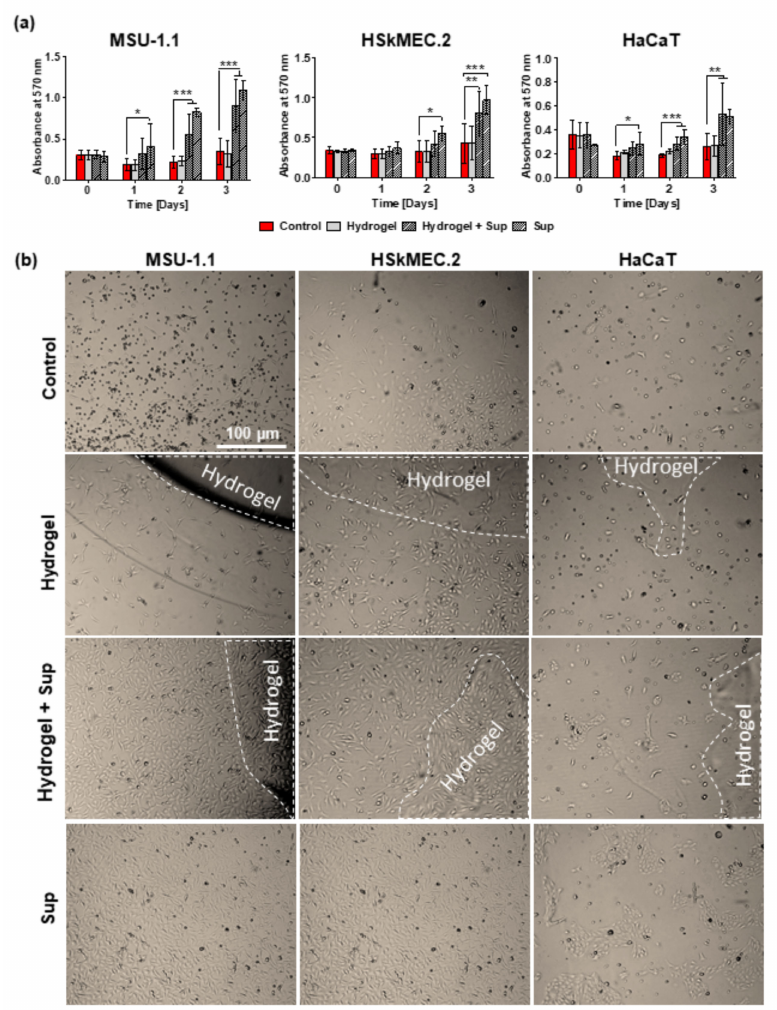
Figure 4. Proliferative activity of skin-derived cells under hydrogel-released HATMSC2 trophic factors. ( a ) Metabolic activity of MSU-1.1, HSkMEC.2 and HaCaT cells cultured in serum-free medium and 1% O 2 was measured by MTT assay at day 0, 1, 2 and 3 following treatment with empty hydrogel, supernatant-loaded hydrogel and 22 µ g HATMSC2 supernatant. Untreated cells were used as a control. Data represent mean ± SEM, n = 3, * p < 0.05, ** p < 0.01, *** p < 0.001. ( b ) Representative images of MSU-1.1, HSkMEC.2 and HaCaT alone, treated with empty hydrogel, supernatant-loaded hydrogel and 22 µ g HATMSC supernatant protein following three-day culture in serum-free medium and 1% O 2 . Areas of the wells covered by the hydrogel are marked by a dashed